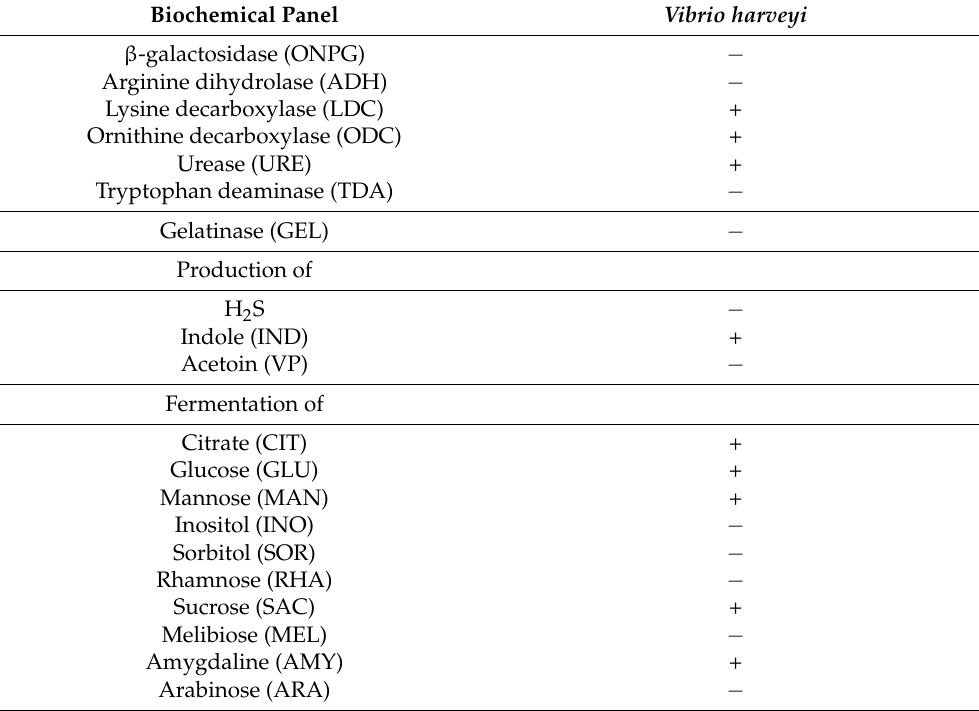
Table 1. Biochemical characteristics of isolated Vibrio harveyi using the API 20E system.